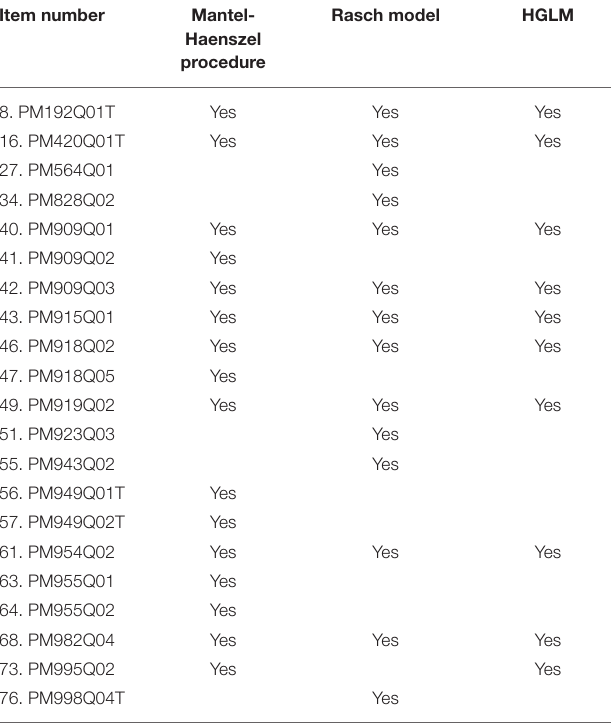
TABLE 7 | Summary of DIF items identified by three